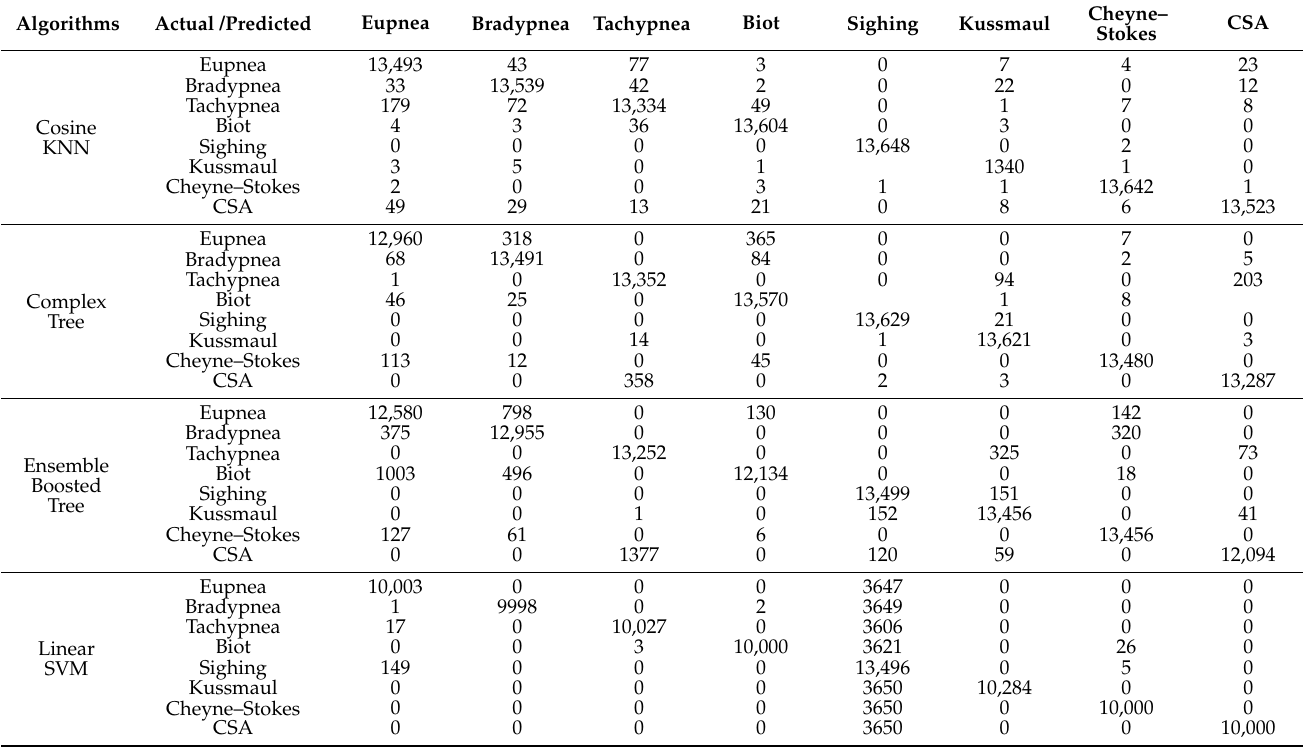
Table 5. Confusion matrix for simulated breathing data.